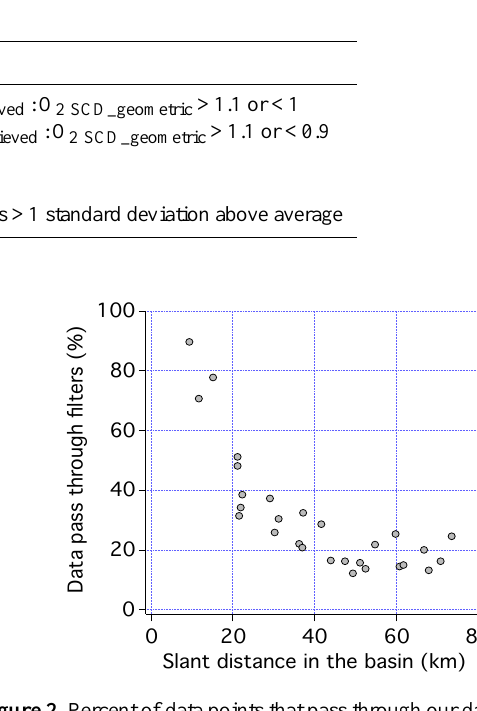
Figure 2. Percent of data points that pass through our data filters as a function of slant distance in the Los Angeles